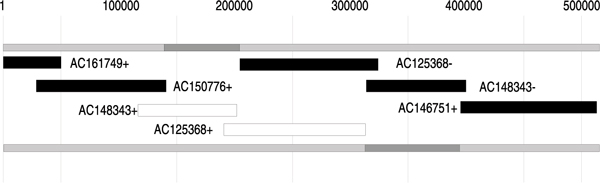
Window Alignment detects alternative assemblies. Displayed is a part of the temporary BAC assembly by the Medicago sequencing consortium drawn to scale using + and - signs to indicate sequence strand. Five BACs (black boxes) are arranged into two assemblies separated by a 60 kbp gap of unknown sequence. However, a long exact match of AC148343+ with AC150776+ suggests another possible assembly indicated by white boxes. See Table 4 for the match quality of all considered overlaps.